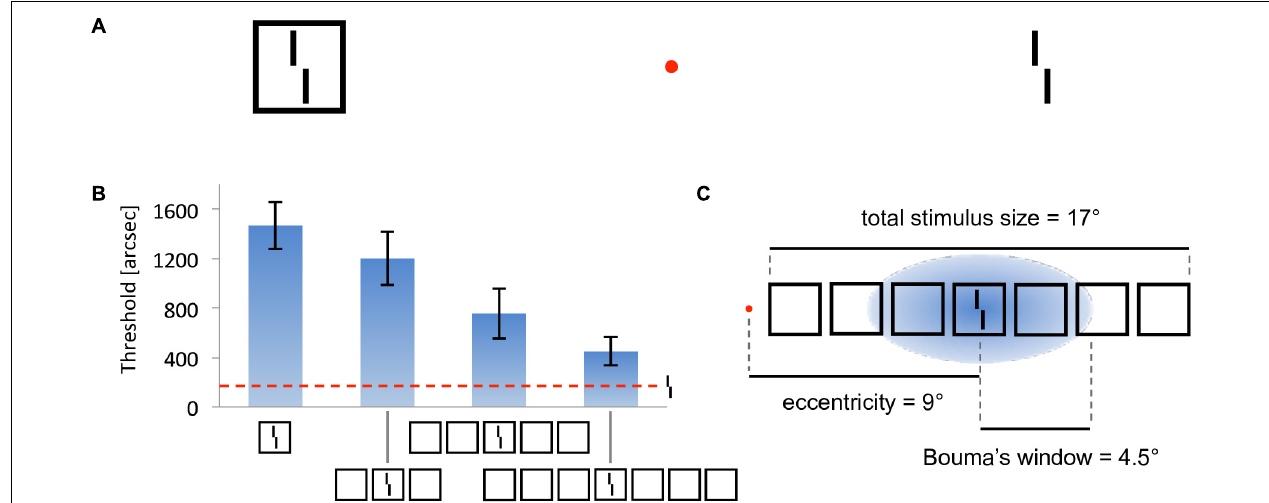
FIGURE 2 | Crowding and uncrowding. Figure reproduced from Doerig et al. (2019). (A) Example of crowding. The task is to determine the direction of the offset of the Vernier target (tilted vertical bars), while looking at the red fixation dot. When the target is flanked by a surrounding square (left), the task is harder than when it is presented alone (right). (B) Uncrowding (experiment 1 of Manassi et al., 2013). Observers performed the Vernier discrimination task as presented in (A) , the stimuli being always displayed in the right visual field, at 9 ◦ of eccentricity. The y -axis shows the target-offset threshold, for which observers correctly discriminate the Vernier offset in 75% of trials (performance is good when the threshold is low). Performance for the target-only condition is shown as the dashed horizontal line. The single-square condition highlights the classic crowding effect. Importantly, adding more flanking squares improves performance gradually (Manassi et al., 2013). We call this effect uncrowding. (C) Performance is not determined by local interactions only. In this display, fine-grained Vernier acuity of about 200” depends on elements as far away as 8.5 ◦ from the Vernier target – a difference of two orders of magnitude, extending far beyond the hypothesized pooling region [here defined as Bouma’s window; Bouma